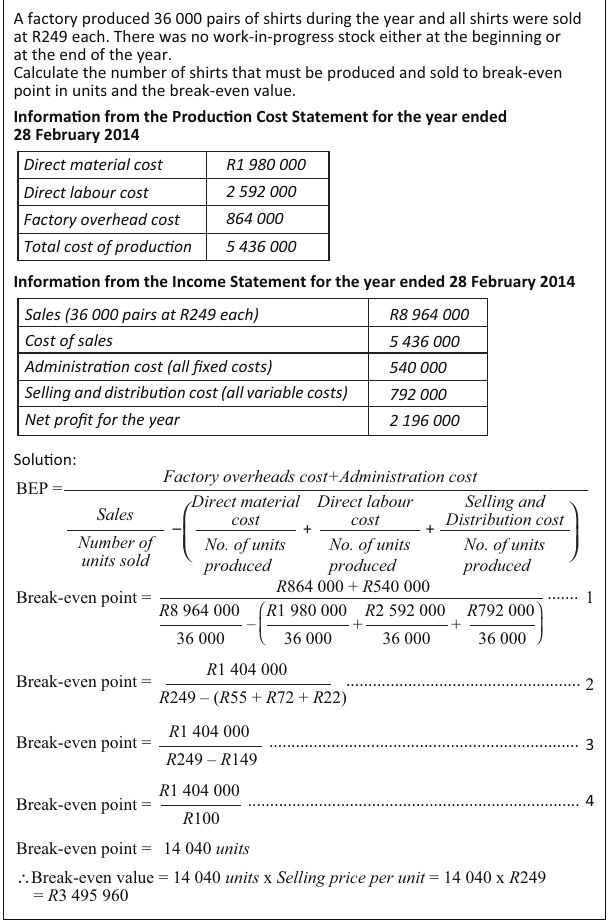
FIGURE 12: Break-even point in units and value